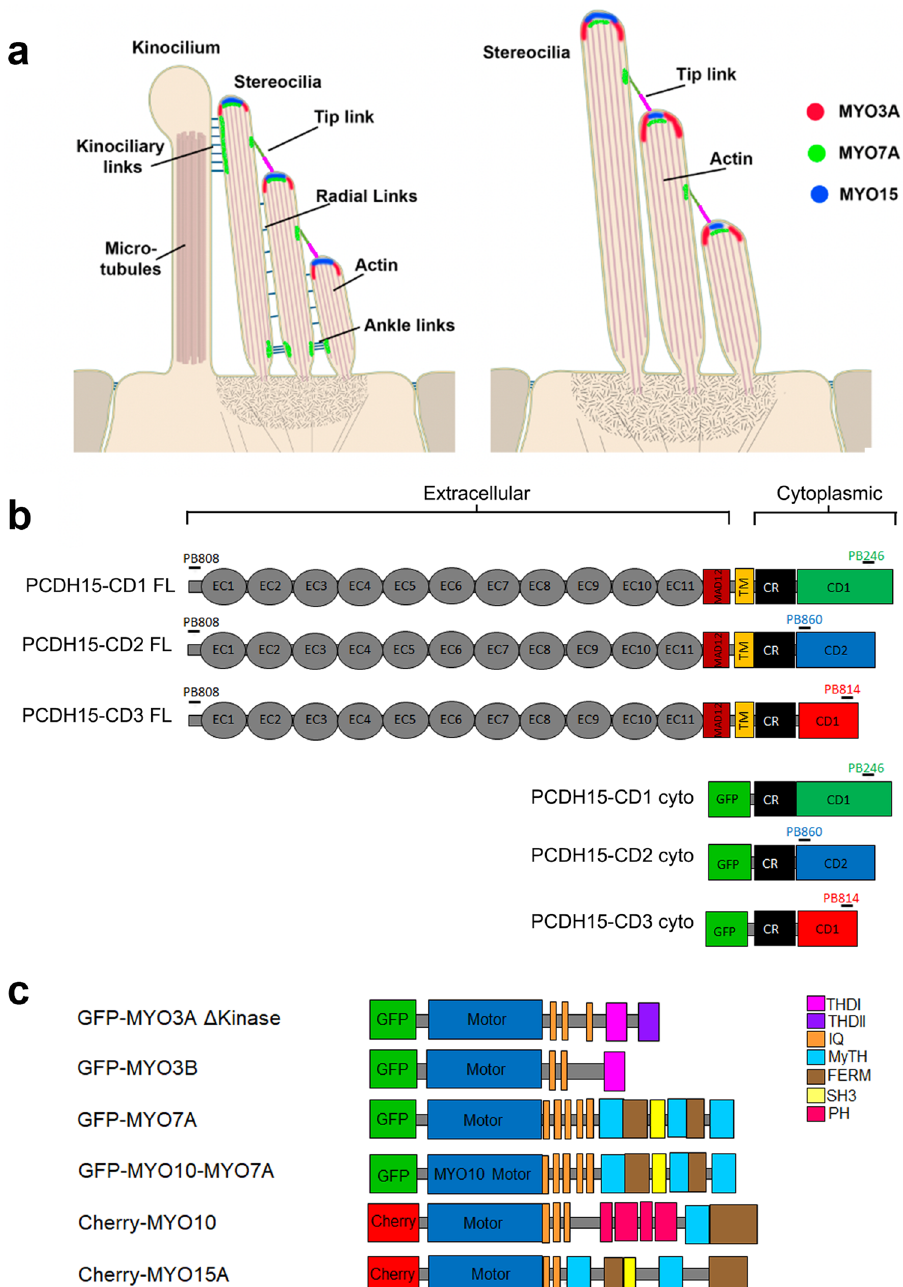
Figure 1. Localization of stereociliary myosin in the hair cell bundle and protein constructs used in this study. ( a ) Localization of MYO3A (red), MYO7A (green), and MYO15 (blue) in the hair cell bundle during development or in the vestibular organs (left panel) and in mature auditory hair cells (right panel). ( b ) Representation of the PCDH15 constructs used in this study. PCDH15 is a large cadherin protein with 11 extracellular calcium-binding (EC) domains, an extracellular linker or membrane adjacent domain (MAD12), a transmembrane 71 segment, and a cytoplasmic domain. The cytoplasmic domain contains a common region (CR) and a unique tail domain specific to each isoform (CD1, CD2, and CD3). Constructs containing the cytoplasmic (cyto) domain of PCDH15-CD1, -CD2 and -CD3 were also generated. ( c ) Diagram of the myosin constructs used in this